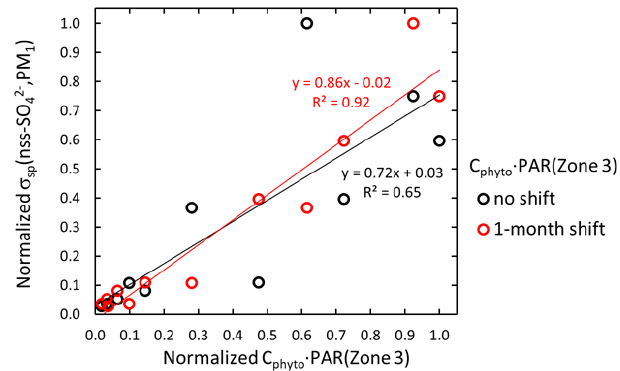
Figure 18. Normalized monthly average scattering coefficients cal- culated from the nss sulfate concentrations of the PM 1 filter samples σ sp (nssSO 2 − ,PM 1 ) at Dome C vs. normalized monthly averages of 4 C phyto PAR in the polar latitude zone with and without a time